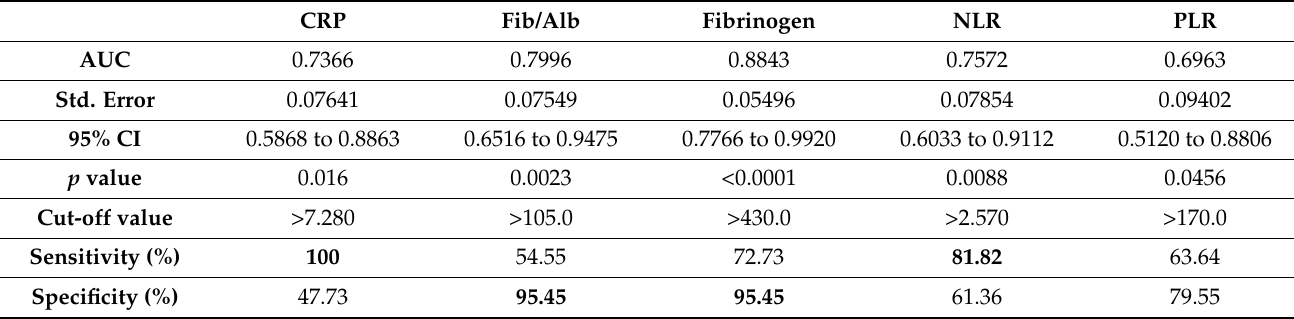
Table 7. Comparison of CRP, Fib/Alb, fibrinogen, and NLR levels using ROC analysis for patients with non-recurrent and recurrent